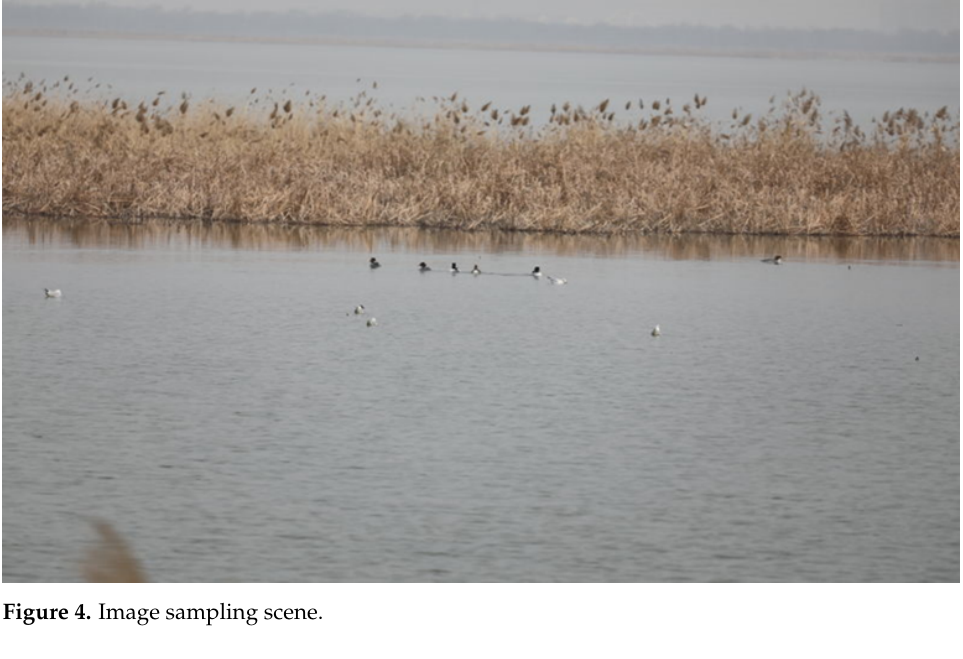
Figure 4. Image sampling scene.